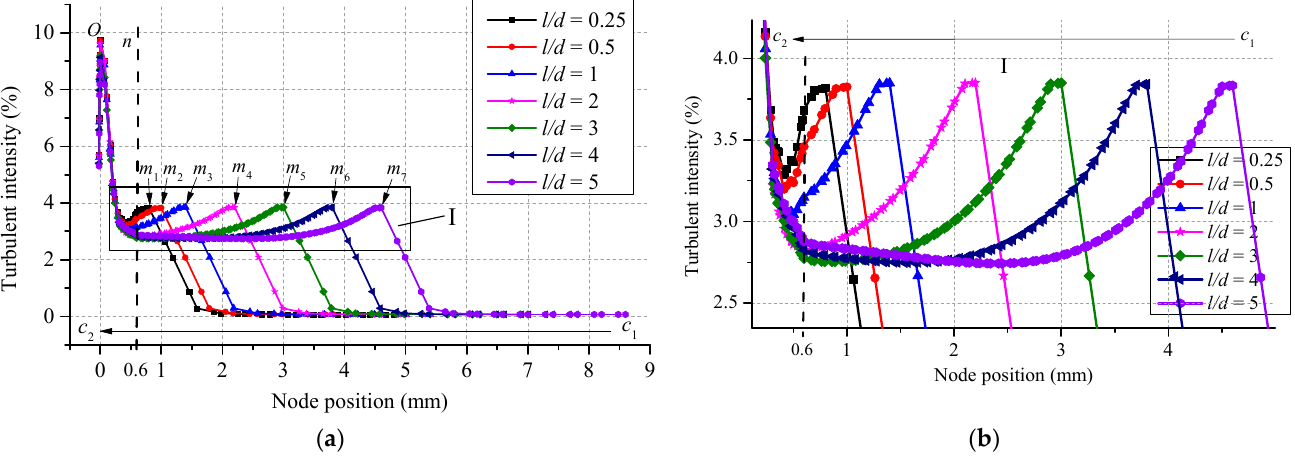
Figure 6. Turbulent intensity patterns of various OLDRs along the line of c 1 – c 2 . ( a ) Turbulent intensities of various OLDRs along the line of c 1 – c 2 ; ( b ) local enlarged view of Ⅰ .